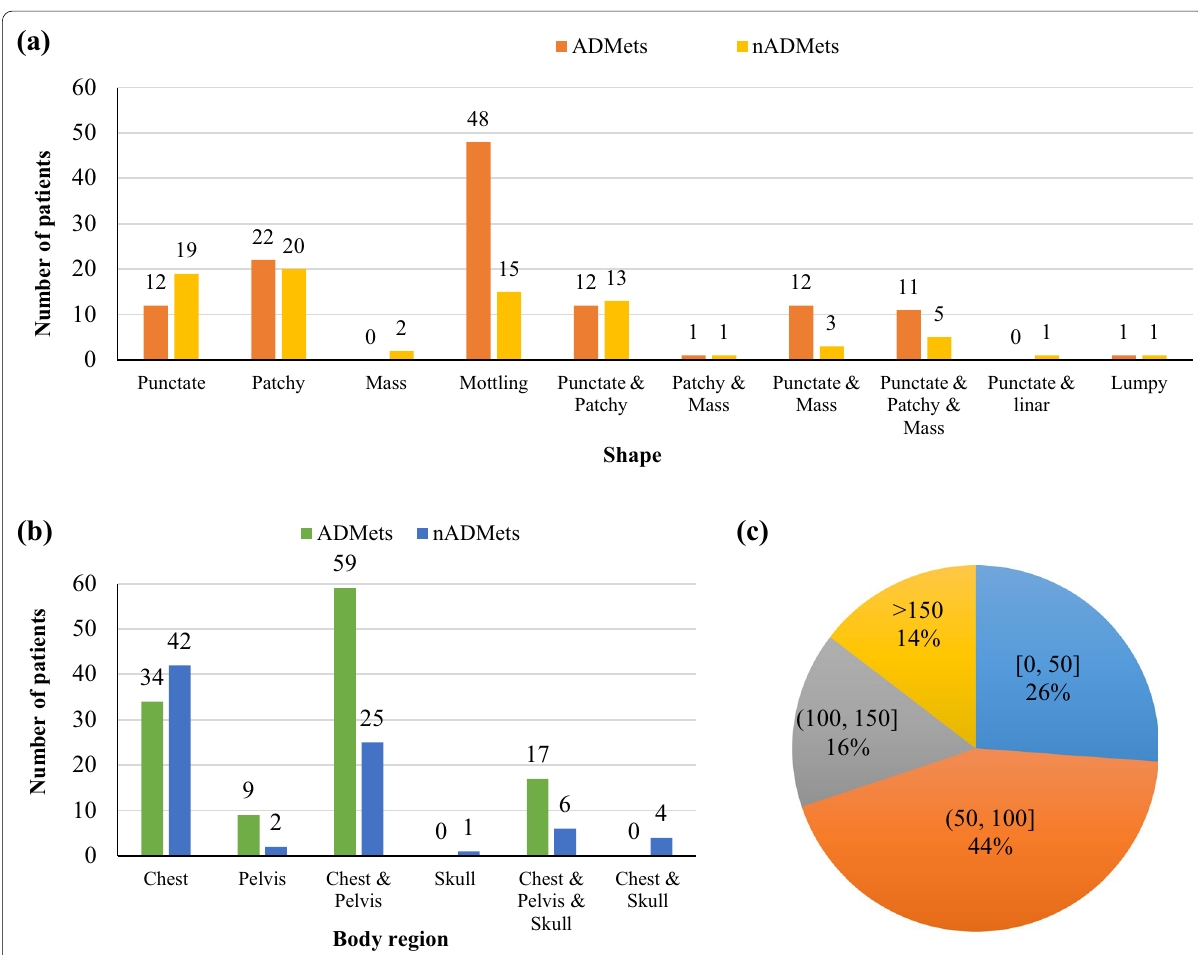
Fig. 12 Characteristics of metastatic lesions in ADMet and nADMet subclasses. a shape; b body region; and ( c ) uptake